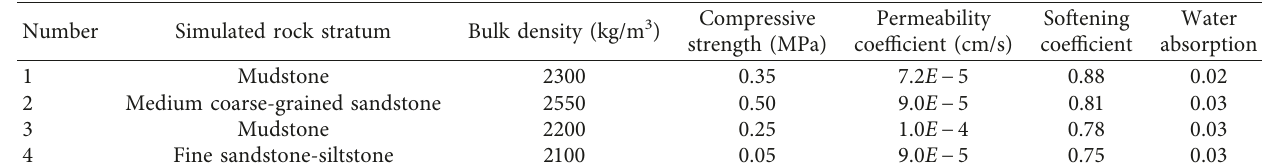
Table 4: Similar material parameters.